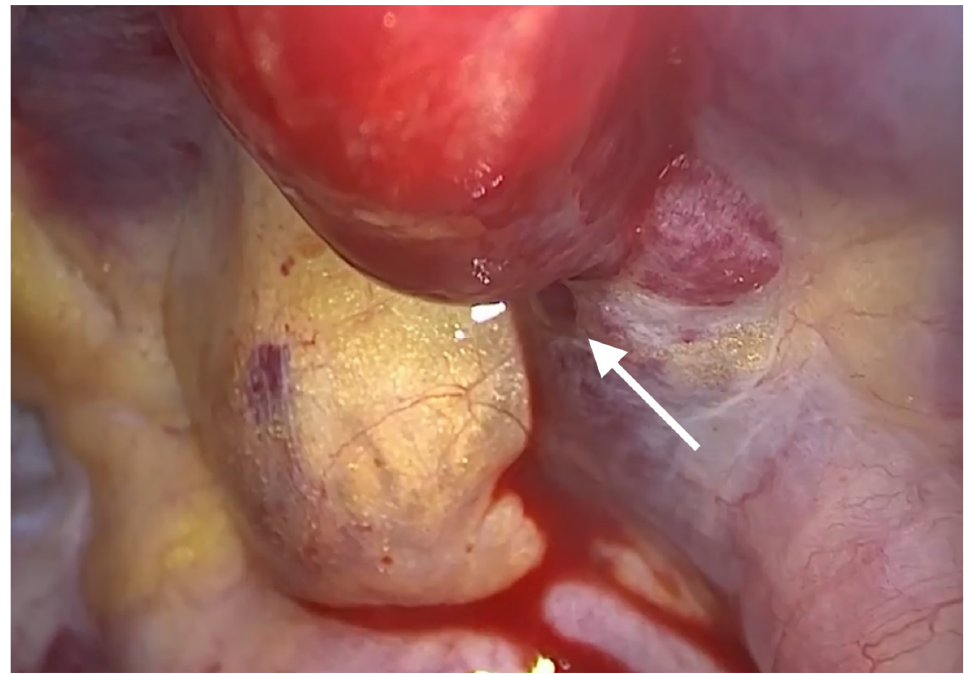
Figure 1. Bleeding of the superior vena cava (arrow) on video-assisted thoracoscopic surgery. Hematoma of the brachiocephalic vein is also seen.